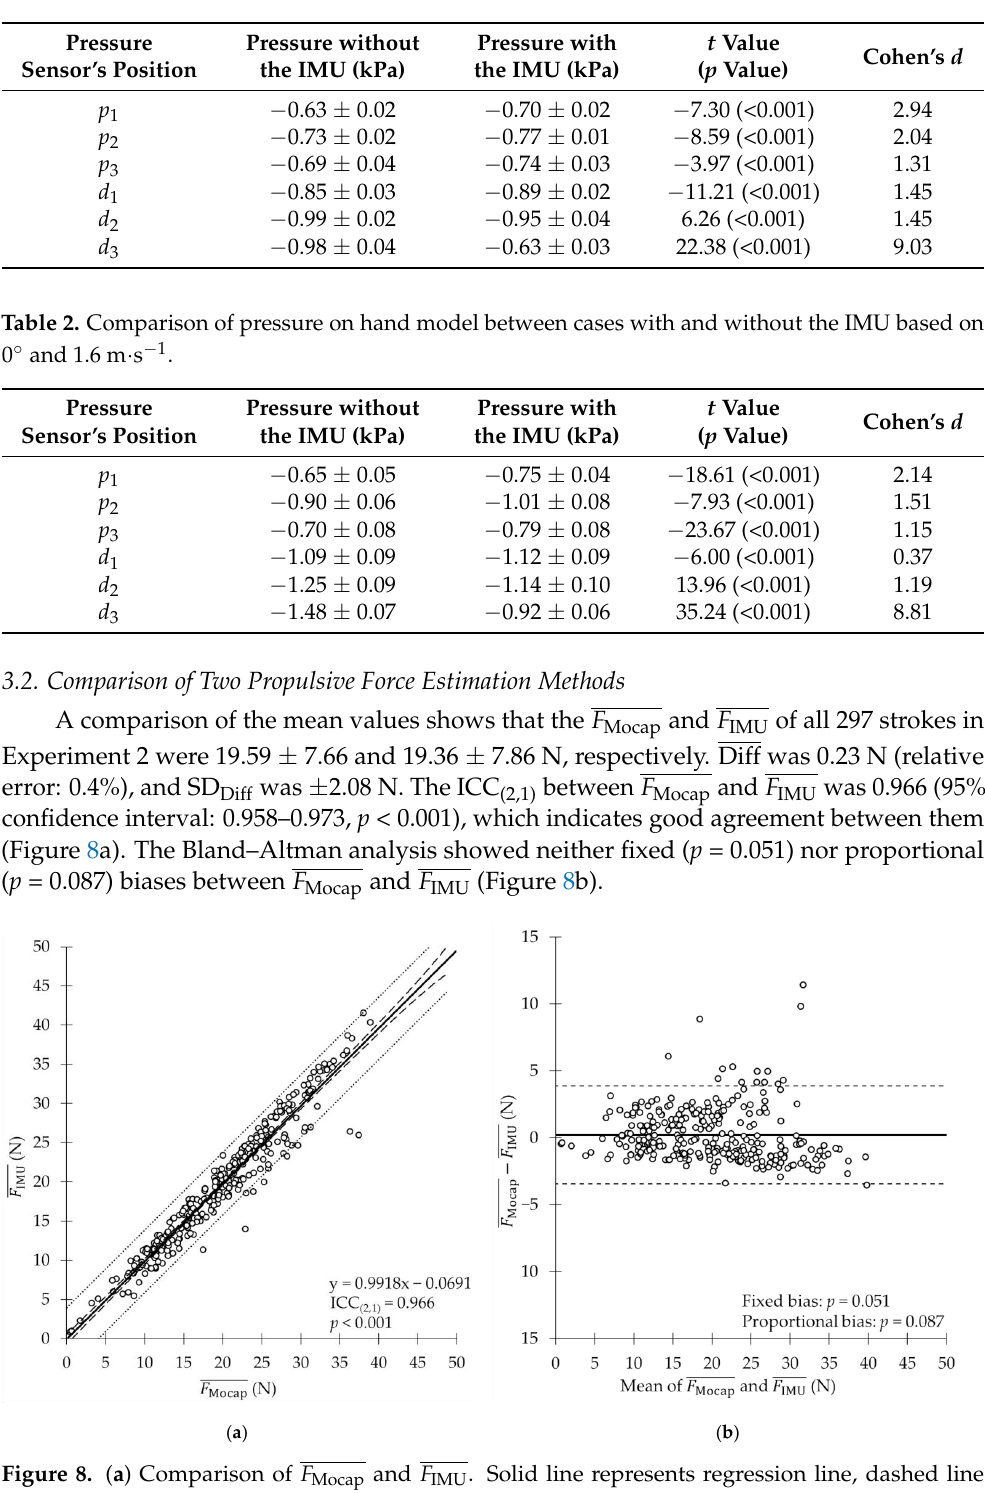
Table 1. Comparison of pressure on hand model between cases with and without the IMU based on 0 ◦ and 1.2 m · s − 1 .